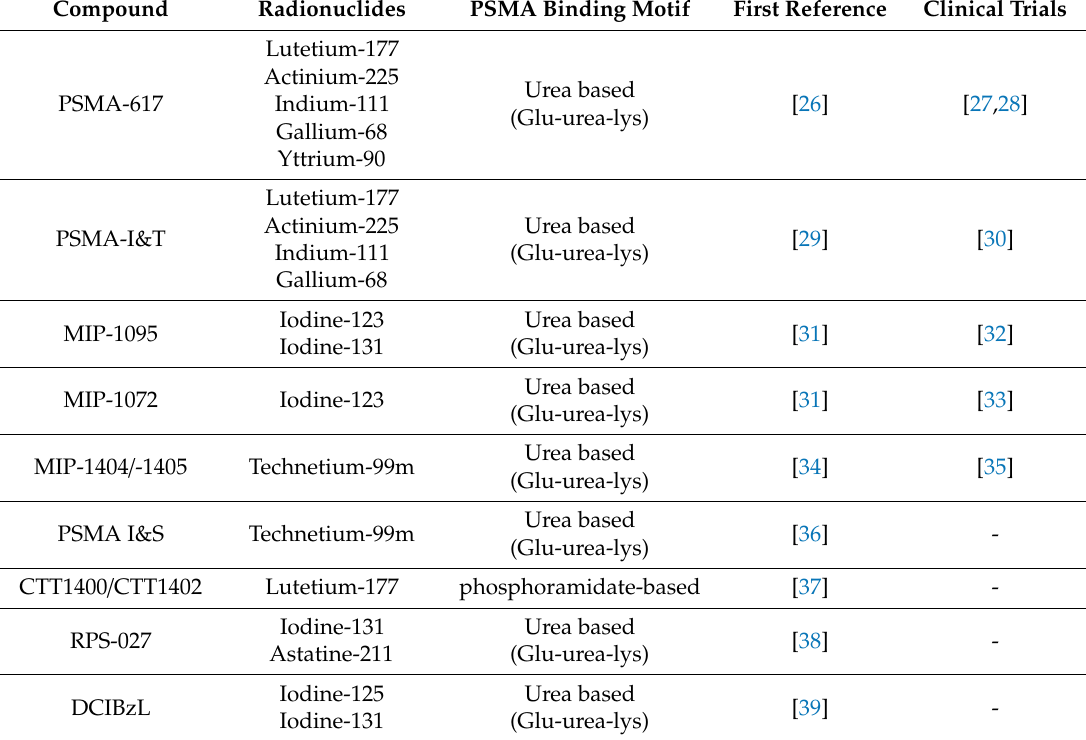
Table 1. Overview of PSMA-targeting small molecule inhibitors suitable for